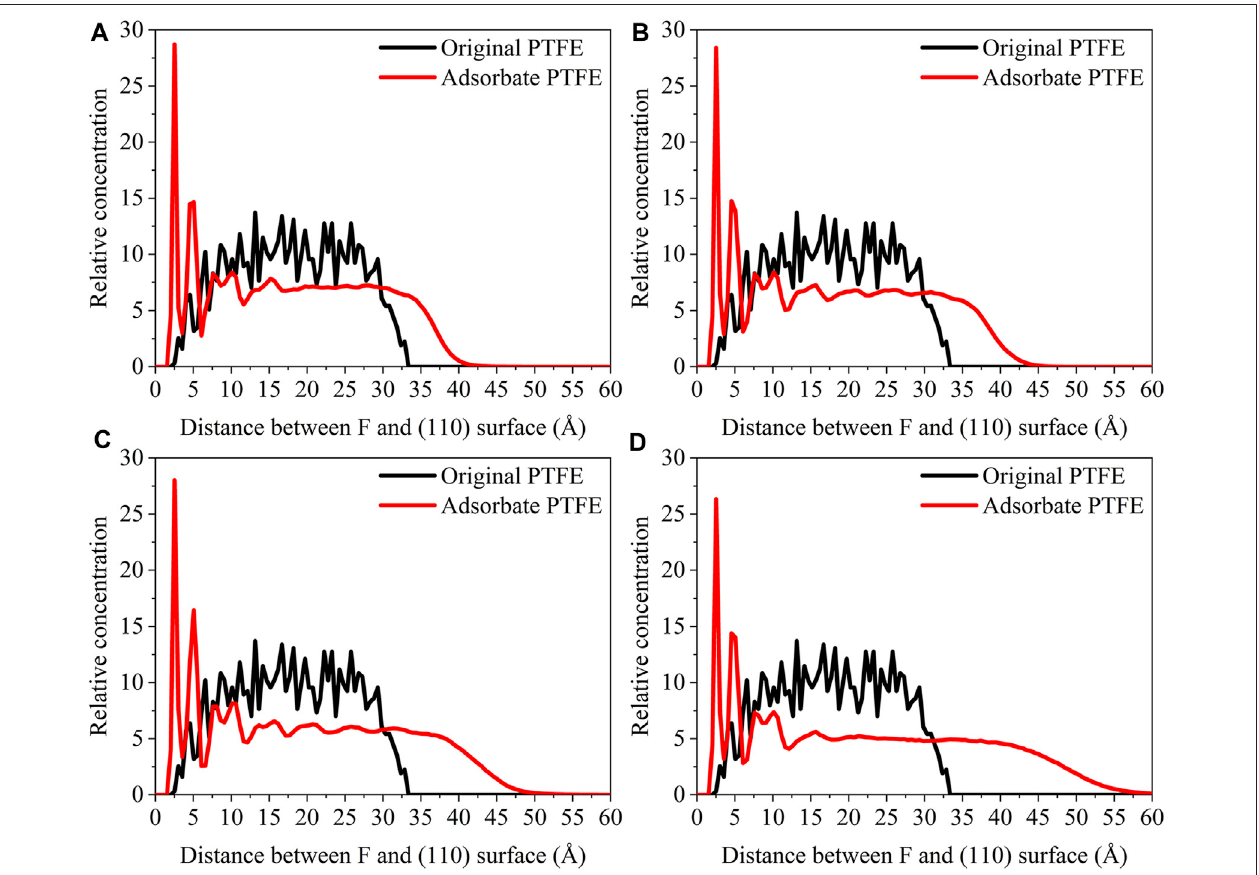
FIGURE 11 | Concentration distribution of F atoms along the z-axis for the (110)/PTFE interface system under different temperatures: (A) 25 ° C, (B) 100 ° C, (C) 200 ° C, and (D) 300 ° C.